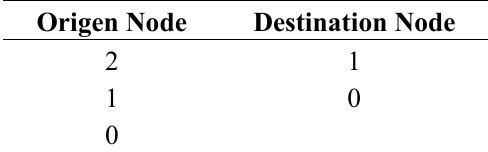
Table 3. Routing table.